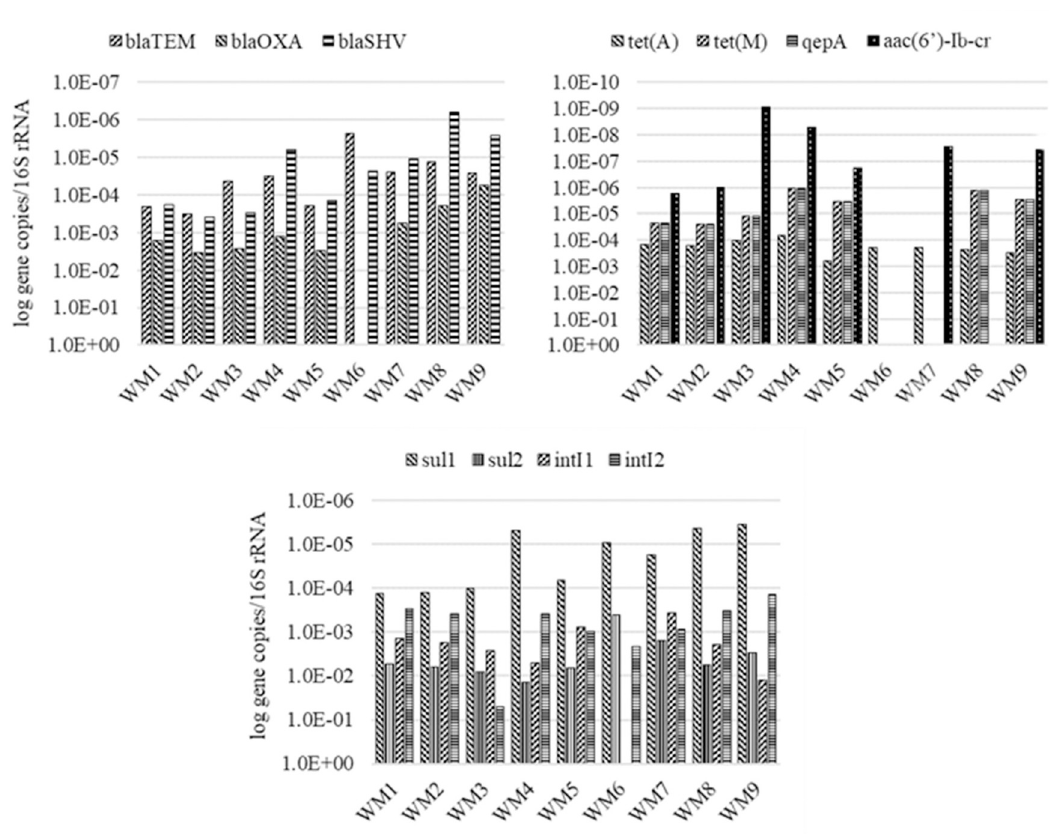
Fig 6. Relative concentration (log gene copies/16S rRNA) of analyzed genes in S-WWTP, both seasons.